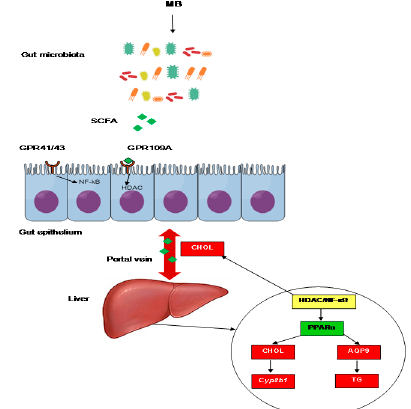
Figure 6. Possible mechanisms involved in effects of monobutyrin (MB) on lipid profile and intestinal permeability. MB is hydrolysed to butyric acid (BUT), altering cecal microbiota composition. When transported to colonic cells via receptors (GPR41/43 or GPR109A), BUT decreases intestinal permeability by enhancing expression of tight junction proteins and suppresses intestinal inflammation and lipid absorption via inhibition of HDAC or NF- κ B. Via the portal vein, BUT can reach the liver where inhibition of HDAC/NF- κ B by BUT leads to reduction in cholesterol and triglycerides/glycerol transporter APQ9 through PPAR α activation. Decreased hepatic cholesterol results in downregulation of bile acid related gene Cyp8b1 . Changes in liver lipids eventually cause decreased lipids in serum and the intestine. SCFA, short-chain fatty acids; GPR, G-coupled protein receptors; NF- κ B, nuclear factor-kappa B; HDAC, histone deacetylase; CHOL, cholesterol; Cyp8b1 , sterol 12-alpha-hydroxylase; PPAR α , peroxisome proliferator-activated receptor alpha; AQP9, aquaporin 9; TG, triglycerides.